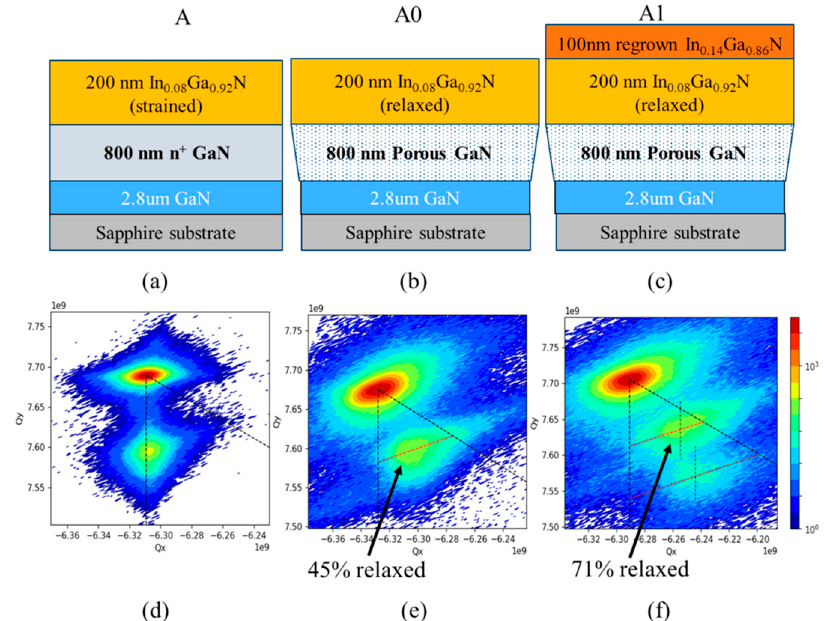
Figure 1. Schematic structure of ( a ) the as-grown sample, ( b ) post porosification, and ( c ) upon regrowth of 100 nm of InGaN, with corresponding RSMs measured using the GaN (1124) reflection to evaluate the InGaN relaxation across the tiles shown in ( d – f ). The black vertical dashed line through the GaN peak corresponds to the fully strained InGaN lattice constant, and the slanted line through the GaN peak corresponds to fully relaxed InGaN lattice constant in ( d – f ). The red dashed lines through the In x Ga 1 − x N and In y Ga 1 − y N peaks in ( e ) and ( f ), correspond to lines of constant indium mole fraction x or y, where the degree of relaxation varies from 0 to 100% from left to right. The In x Ga 1 − x N peak in ( e ) shifted to the right along the red dashed line in ( f ) as a result of regrowth of In y Ga 1 − y N layer. The vertical dashed lines through the In x Ga 1 − x N and In y Ga 1 − y N peaks in ( f ) show a slight o ff set corresponding to about 20% lattice mismatch between the two